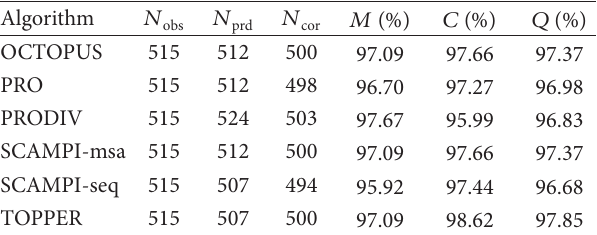
T 3: Prediction performance of various algorithms in trans- membrane region level.